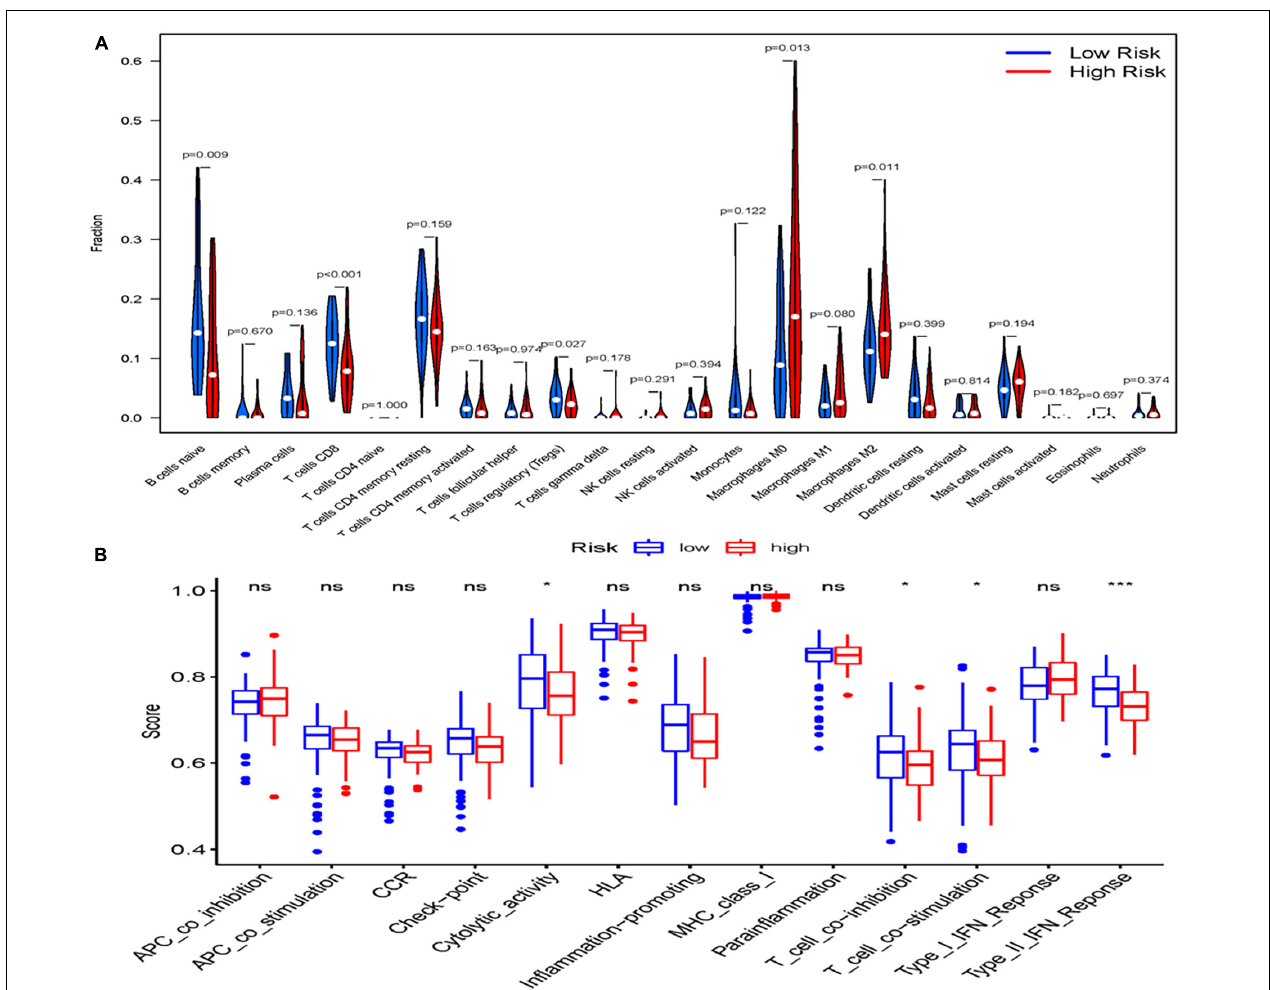
FIGURE 6 | Landscape of Immune Cell Infiltration in pancreatic cancer. (A) The infiltration of 22 immune cell types in the high- and low-risk groups in the TCGAcohort. (B) Comparison of the 13 immune-related functions between the high-and low-risk groups in the TCGA cohort. Adjusted P -values were showed as: ns, not significant; * P < 0.05; *** P <